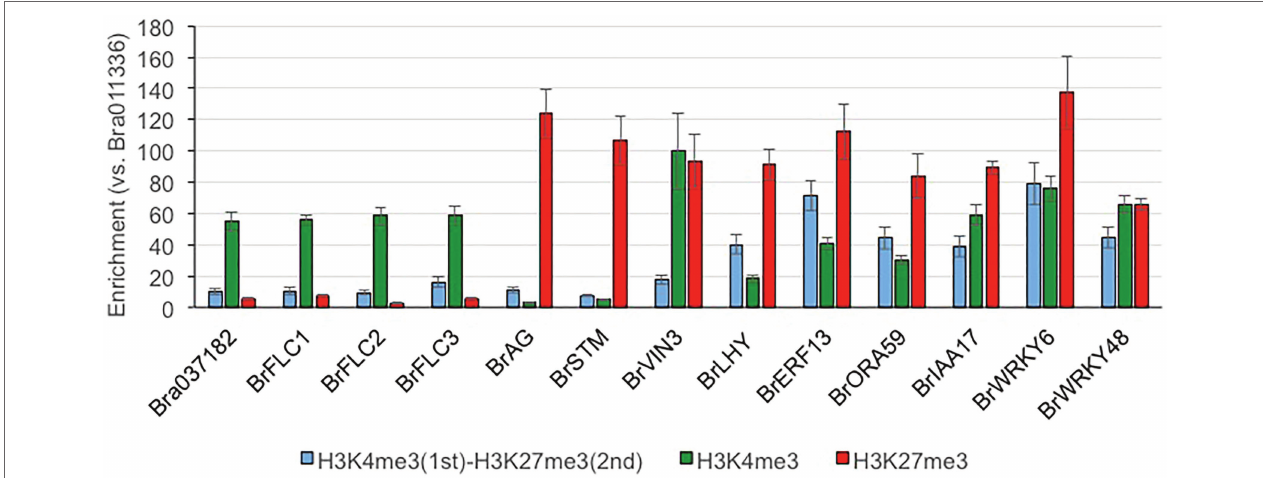
FIGURE 3 | Sequential ChIP-qPCR in RJKB-T24. Bra011336 that does not have H3K4me3 and H3K27me3 is used as reference gene for qPCR. Bra037182 and three BrFLC paralogs are H3K4me3-marked genes, and BrAG and BrSTM are H3K27me3-marked genes. BrVIN3 , BrLHY , BrERF13 , BrORA59 , BrIAA17 , BrWRKY6 , and BrWRKY48 had both H3K4me3 and H3K27me3 marks by ChIP-seq, and distribution of these modification in each gene was shown in Supplementary Figures S5, S9 . Values are means ± standard error (s.e.; three biological and technical replicates) of relative H3K4me3, H3K27me3, or H3K4me3/ H3K27me3